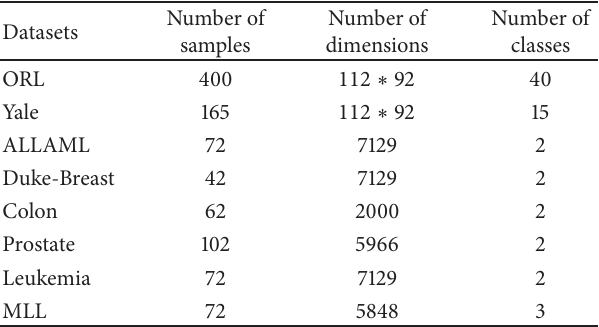
Table 1: Statistics of the data sets we